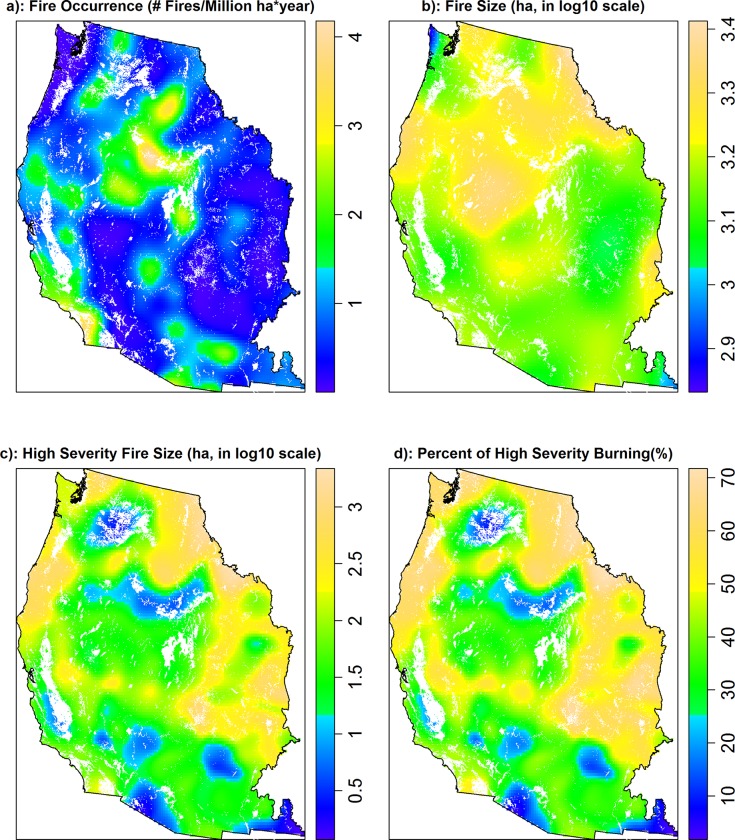
Spatial distributions of (a) smoothed density of large fires (fires per million ha per year), (b) smoothed mean fire size (ha), (c) smoothed mean high severity fire size (ha), and (d) smoothed percent of high severity burning (%) in the western US.Non-burnable areas are displayed in white.